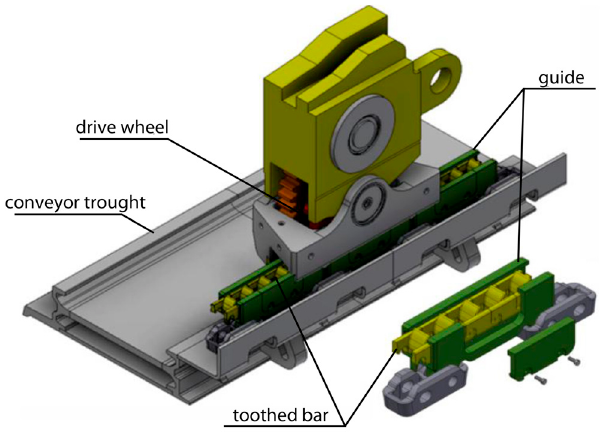
Figure 1. Haulage system 3D model [13].